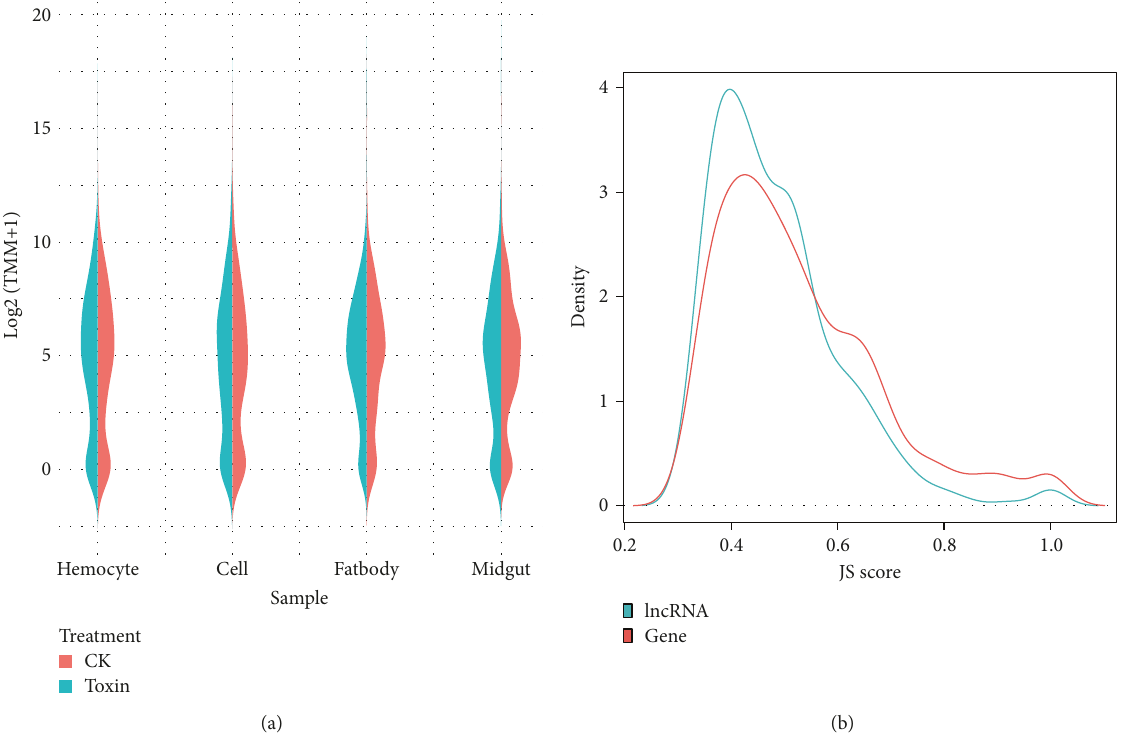
Figure 7: Characteristics of di ff erentially expressed lncRNAs. (a) Violin plot of the expression pro fi le of di ff erentially expressed lncRNAs. (b) Density plot of Jensen-Shannon score of di ff erentially expressed lncRNAs and